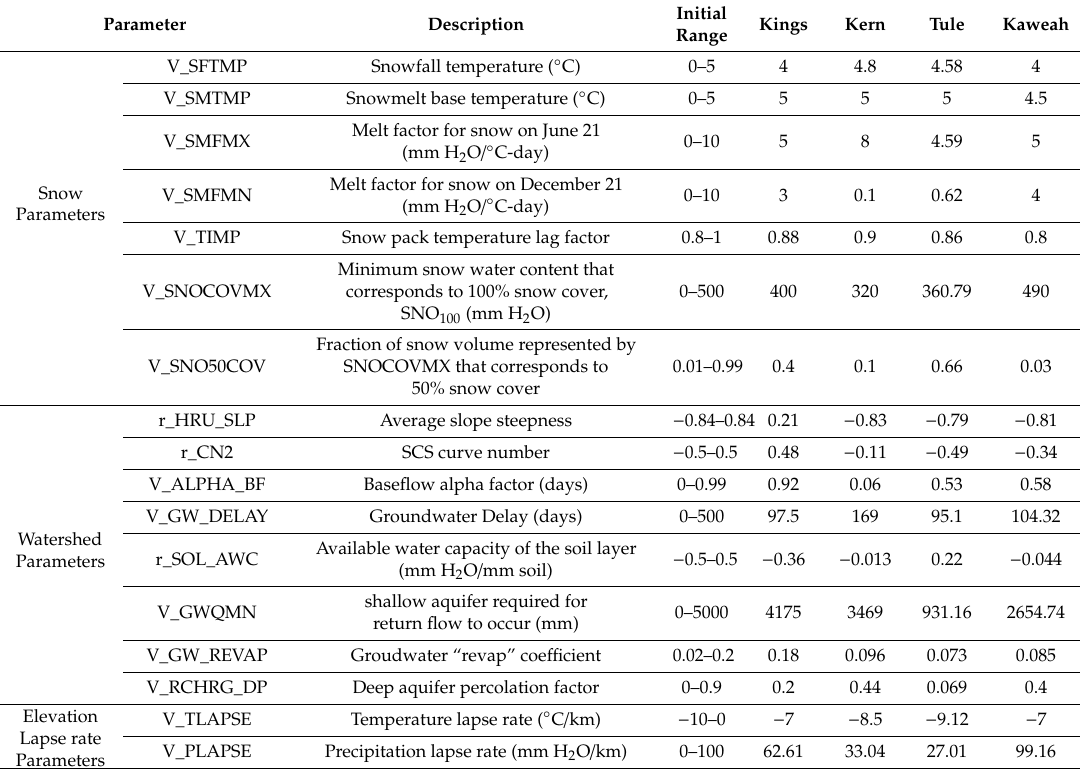
Table 1. Parameters included in the SWAT model calibration, their initial ranges, and the final calibrated parameter values.